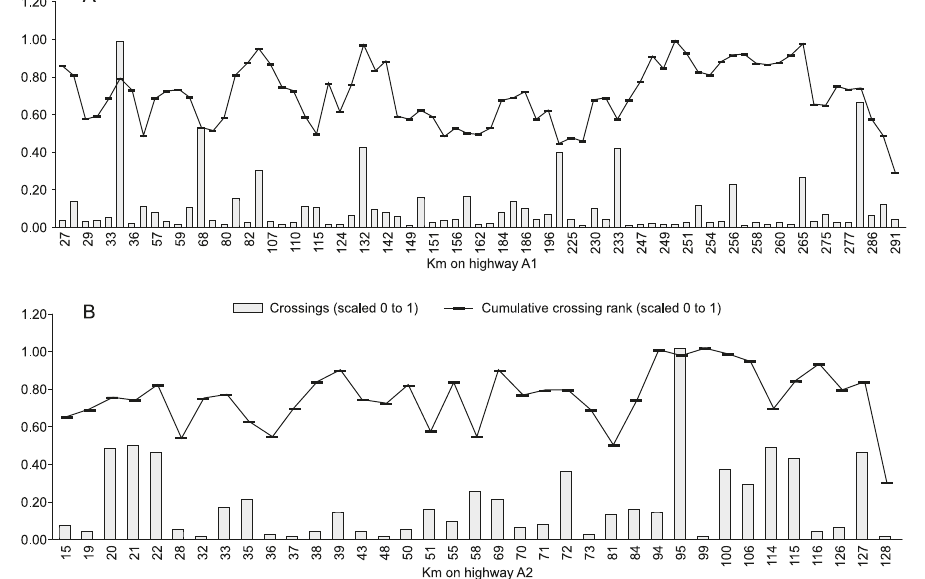
Figure 5. Moose crossings and their cumulative crossing ranks on 1 km segments of highways A1 (A) and A2 (B).